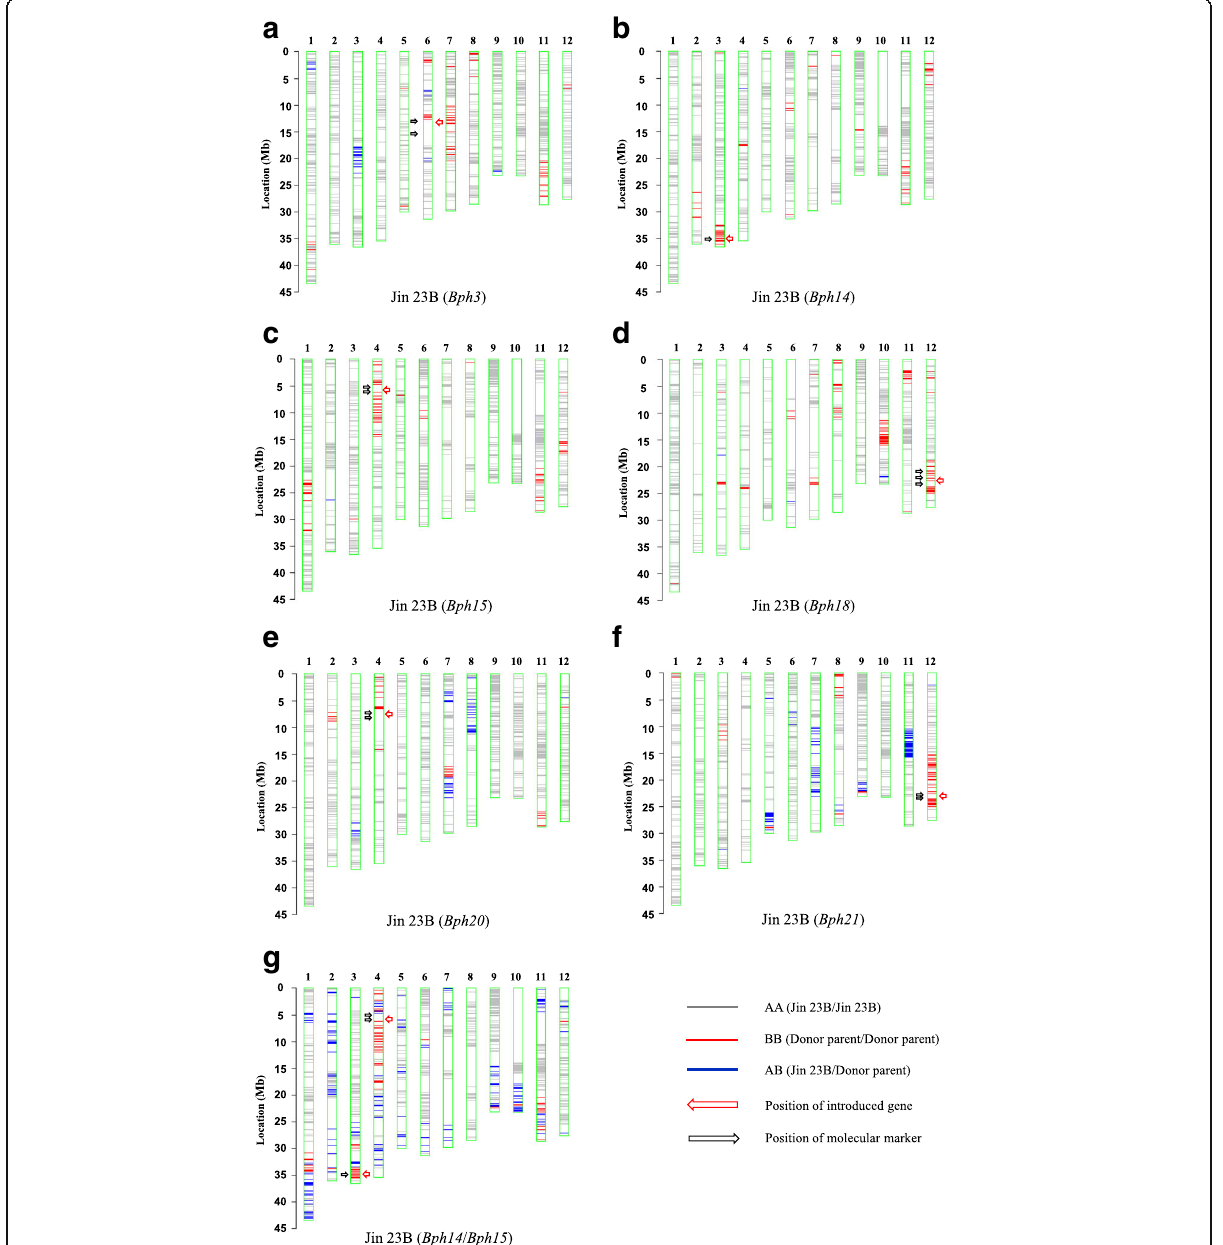
Fig. 2 Haplotype maps of genetic background profiling of improved Jin 23B using the RICE6K array. ( a ) Jin 23B ( Bph 3), ( b ) Jin 23B ( Bph 14), ( c ) Jin 23B ( Bph 15), ( d ) Jin 23B ( Bph 18), ( e ) Jin 23B ( Bph 20), ( f ) Jin 23B ( Bph 21), ( g ) Jin 23B ( Bph 14/ Bph 15). Donor parents included 4 cultivars: PTB33 ( Bph3 ), B5 ( Bph14 / Bph15 ), IR65482 – 7 – 216-1-2 ( Bph18 ) and IR71033 – 121-15 ( Bph20 / Bph21 ). Arrowheads with red color indicate the positions of introduced gene. Arrowheads with black color indicate the positions of molecular marker used in marker-assisted selection backcross breeding